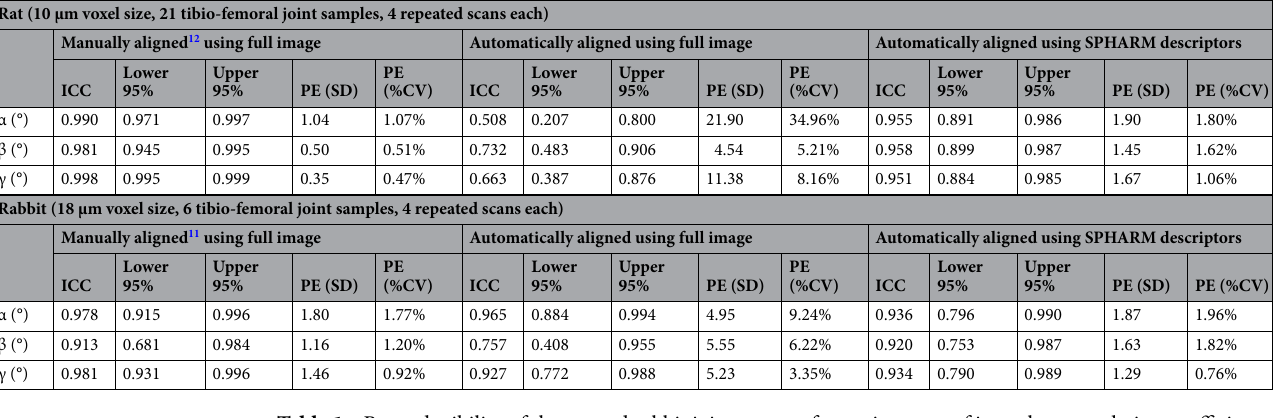
Table 1. Reproducibility of the rat and rabbit joint centre of mass in terms of intraclass correlation coefficient (ICC) and precision errors (PE) expressed in absolute and a percentage of the coefficient of variation of the repeated measure (α: angle with respect to x-axis, β: angle with respect to y-axis, γ: angle with respect to z-axis).